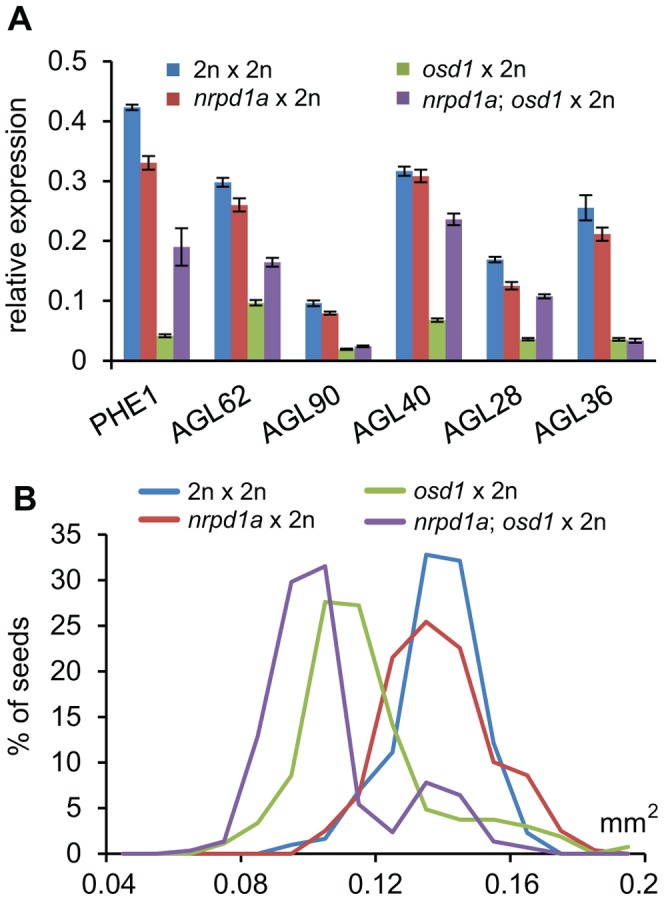
Maternal Loss of NRPD1a Does Not Restore Wild-Type Levels of AGL Expression and Wild-Type Seed Size.(A) Quantitative RT-PCR analysis of PHE1, AGL62, AGL90, AGL40, AGL28 and AGL36 in seeds derived from crosses 2n×2n, nrpd1a/nrpd1a×2n, osd1/osd1×2n, and nrpd1a/nrpd1a; osd1/osd1×2n at 3 DAP. Error bars indicate s.e.m. (B) Distribution of seed sizes from different crosses. A minimum of 250 seeds was analyzed for each cross.